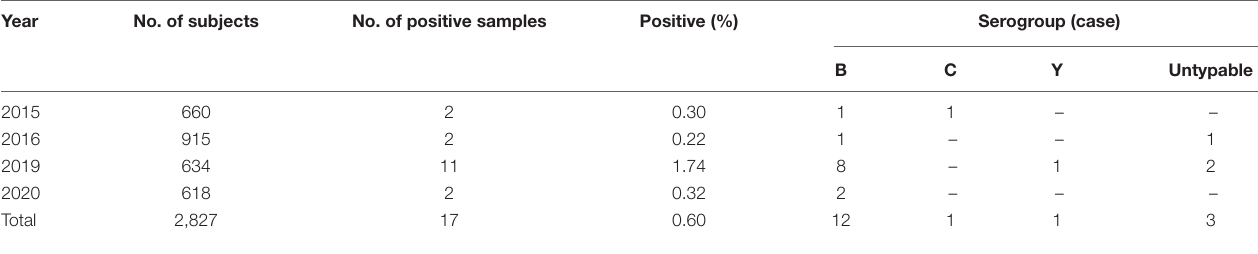
FIGURE 2 | Serogroup-specific incidence of MD during 2011–2020 in Zhejiang Province. TABLE 2 | Surveillance on carriage rate of Nm in healthy population during